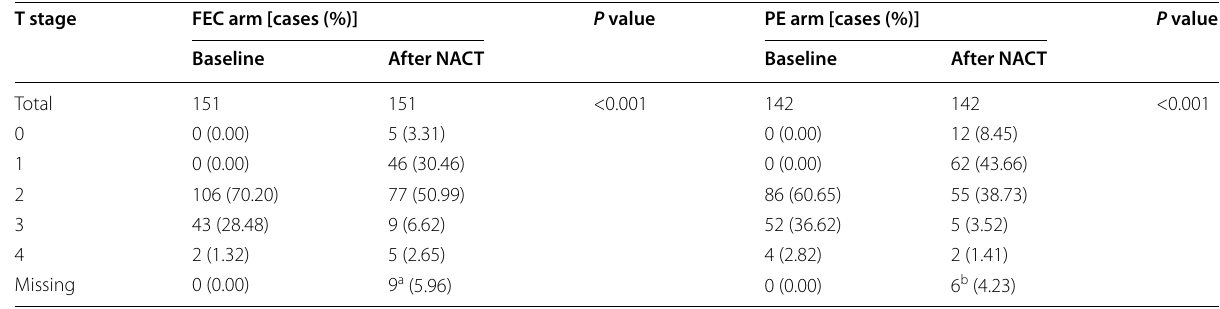
Table 3 Clinical down-staging effects of the FEC and PE regimens on locally advanced breast cancer